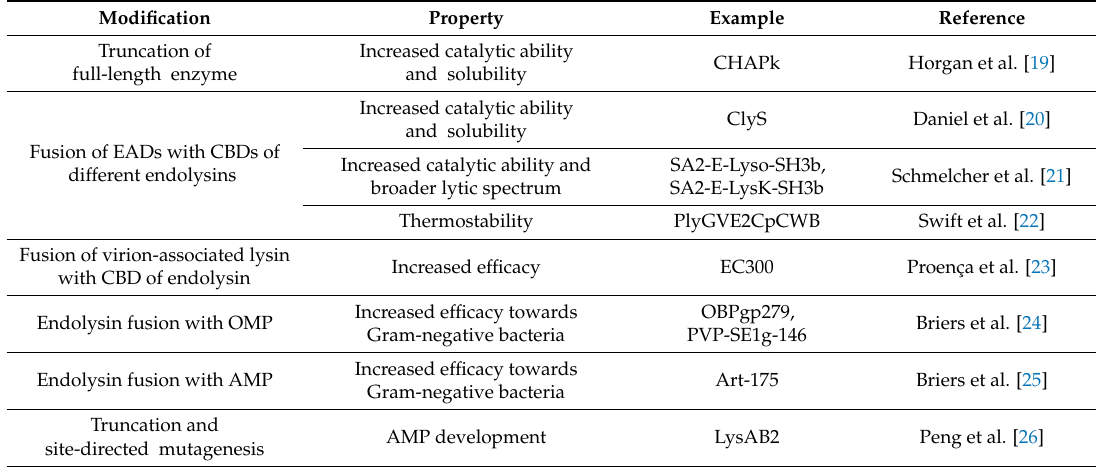
Table 1. Possible molecular engineering strategies with potential